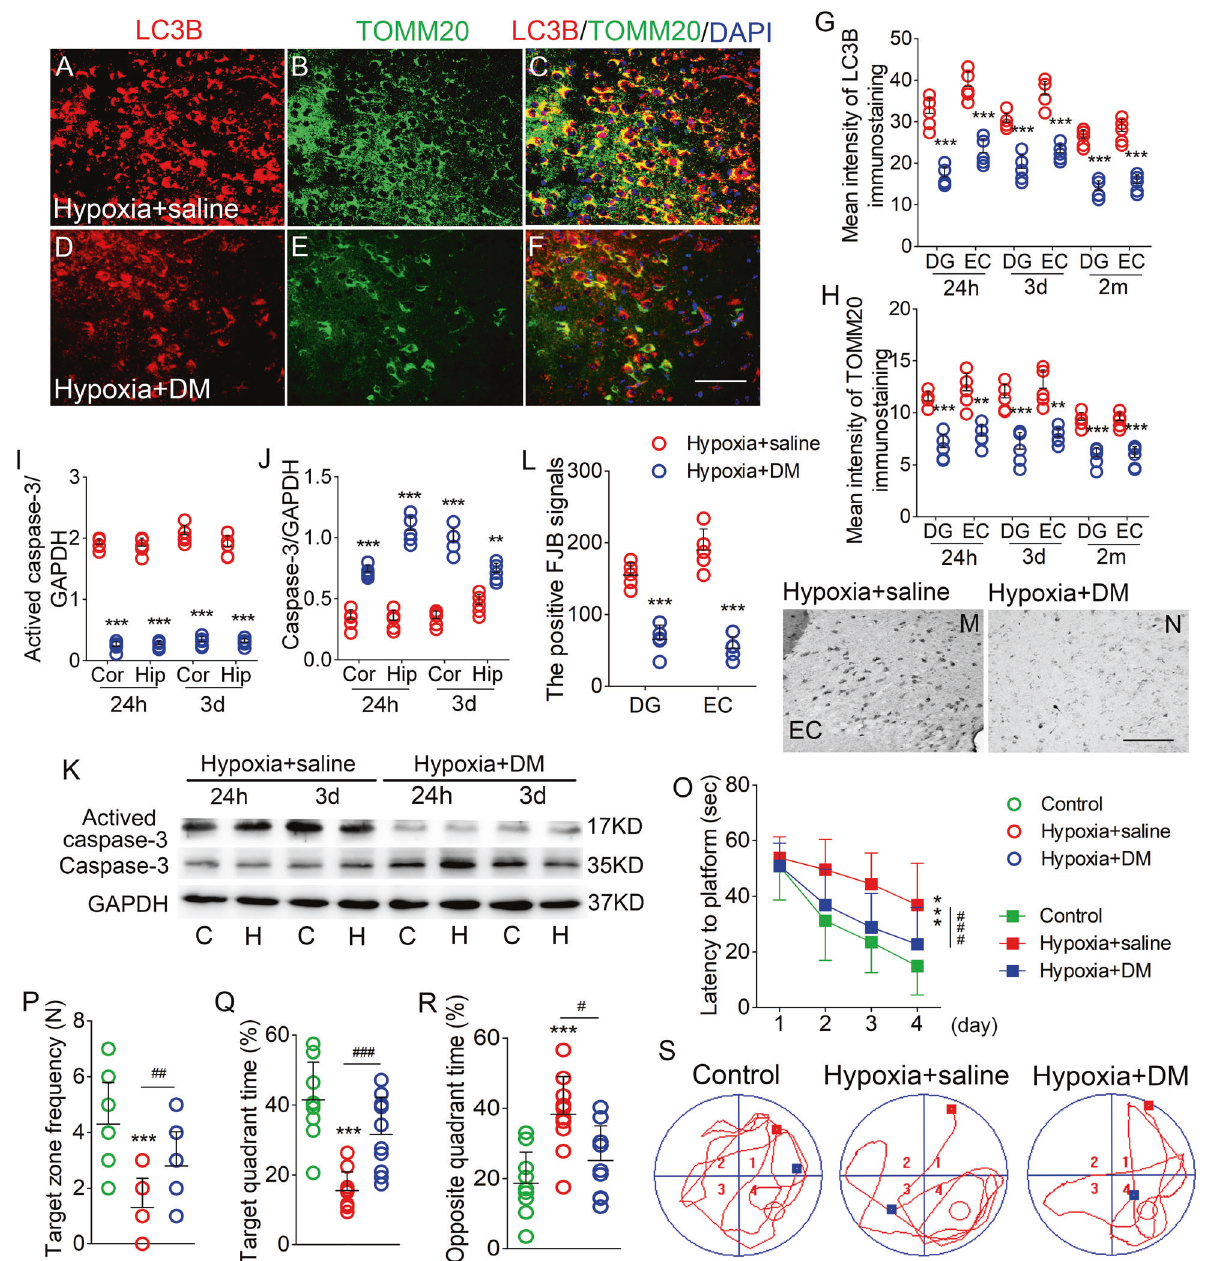
platform crossings. Q Target quadrant time (%), and ( R ) Opposite quadrant time (%). S Representative tracking. ** P < 0.01, and *** P < 0.001, all compared with controls (One-way ANOVA). # P < 0.05, ## P < 0.01, and ### P < 0.001, compared with that in hypoxia + saline group (One-way ANOVA with Dunnett ’ s T3 post-hoc